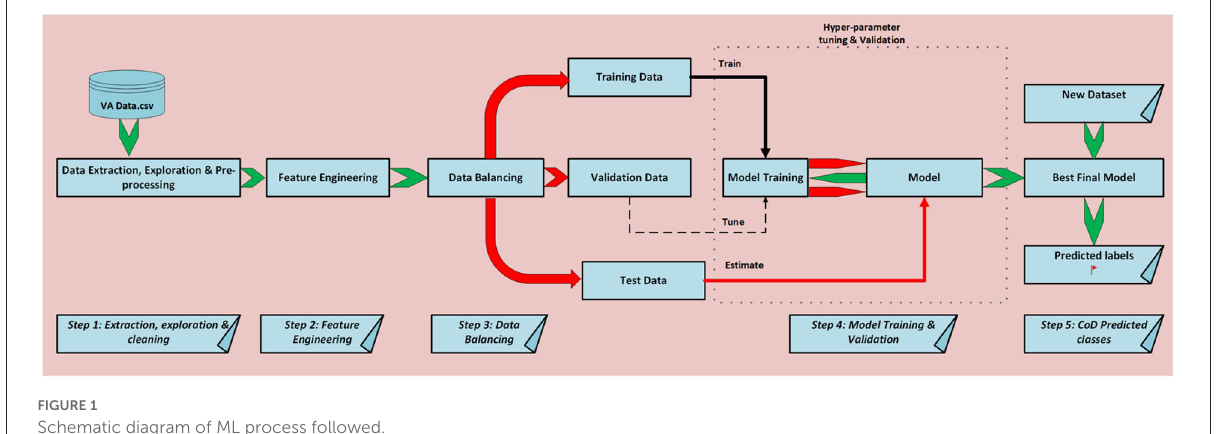
FIGURE1 Schematic diagram of ML process